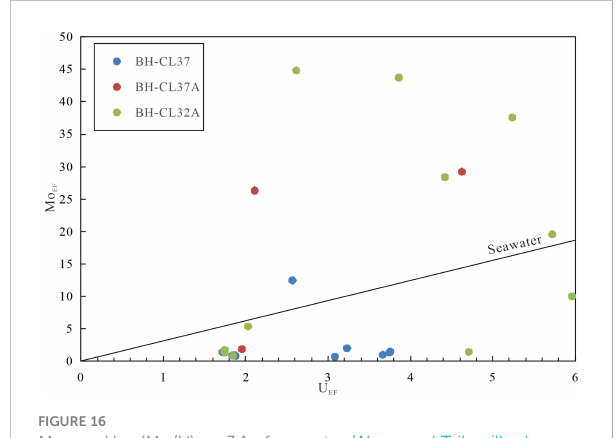
FIGURE 16 Mo EF vs U EF . (Mo/U) EF =3.1 of seawater (Algeo and Tribovillard,